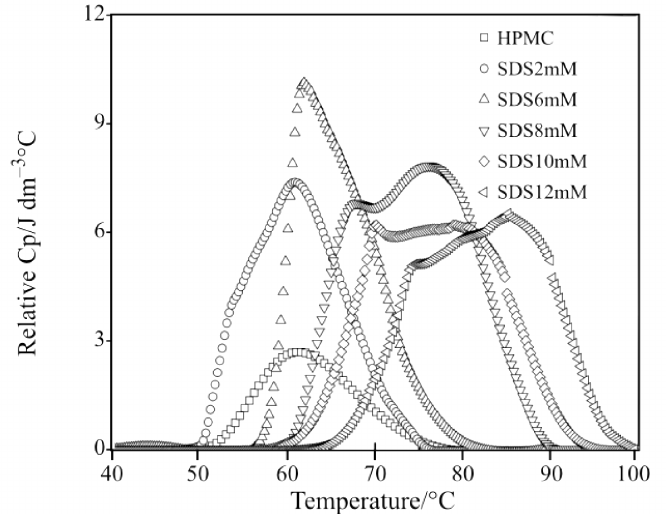
Figure 7. Relative heat capacity of 1.0 wt% HPMC solutions with different concentrations of sodium n-dodecyl sulfate (SDS) as a function of solution